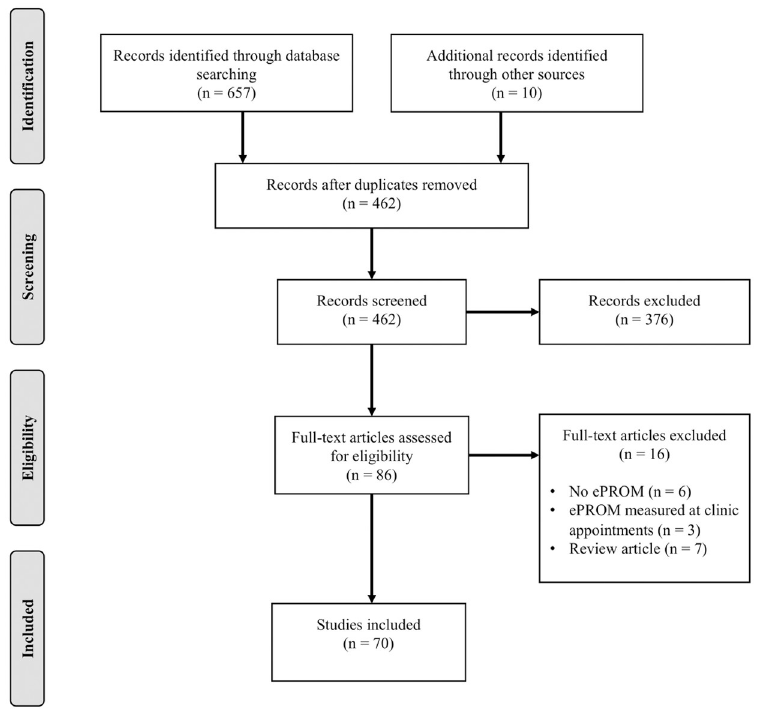
Fig 1. PRISMA flow diagram of the review